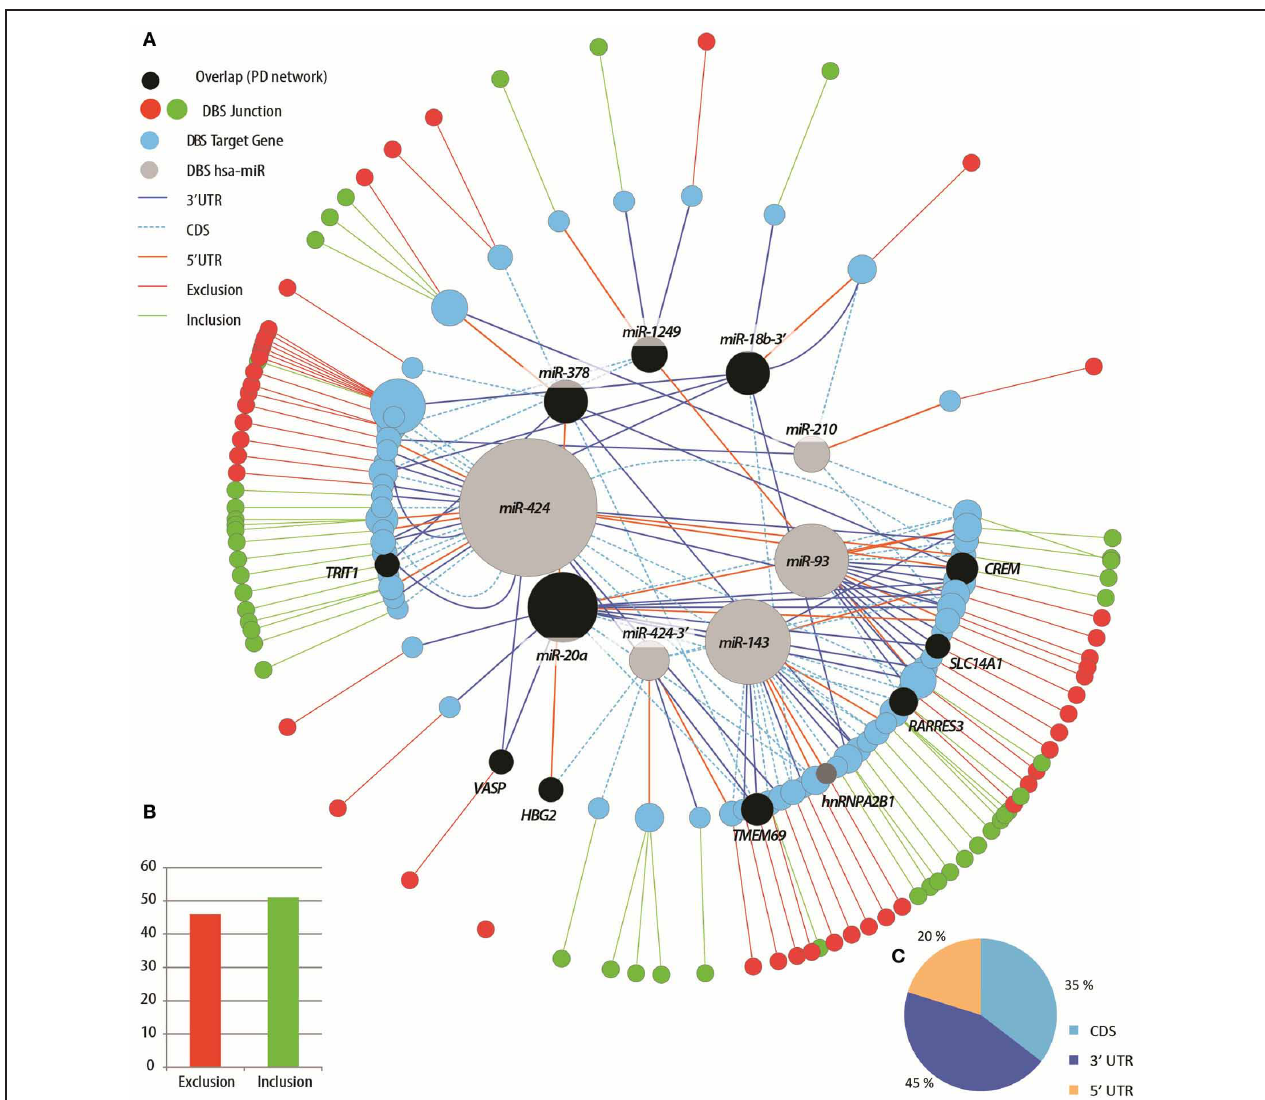
FIGURE 7 | The treatment induced network partially overlaps with the disease network. (A) A circular tree layout network of connections between miRNAs that exhibited differential expression following DBS neurosurgery as compared with the pre-DBS (non-stimulated) state, and their predicted target genes that exhibited alternative splicing changes in PD patients following the DBS treatment. External circle: red node color indicates exclusion event in the predicted target splice junction and green—exclusion. Larger node size indicates higher number of connections. The color of edges represents the gene region in which the binding is predicted to occur (5 (cid:2) , 3 (cid:2) -UTR or coding sequence, CDS).